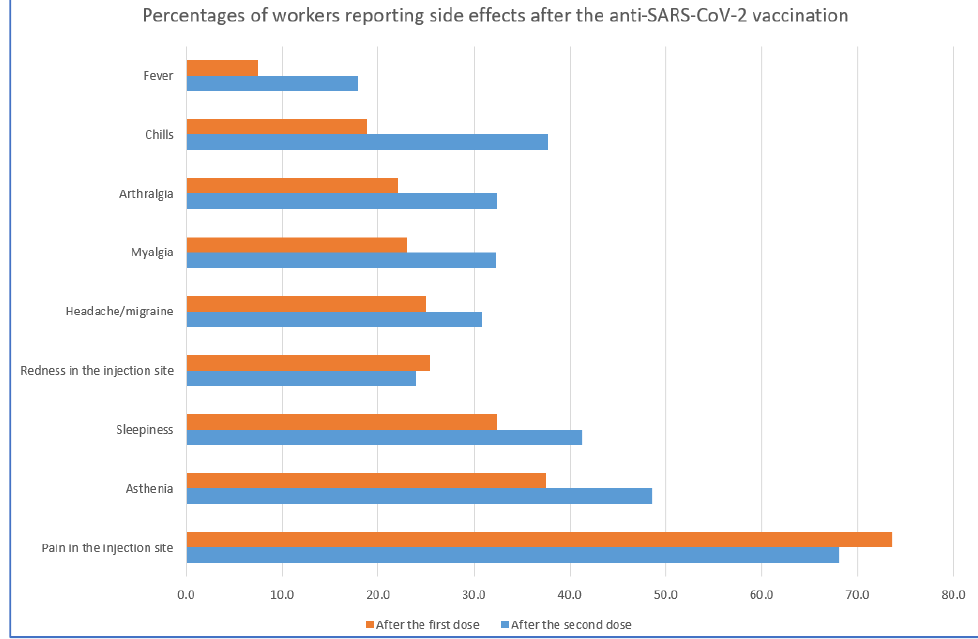
Figure 1. Percentage of workers reporting adverse effects after the first (red bar) and the second (blue bar) dose of the BNT162b2 anti-SARS-CoV-2 vaccine. NB: data on other adverse effects (including anaphylaxis, syncope, dyspnea, diarrhea, erythema, abdominal pain, itch, vertigo and taste alterations) with a frequency <8% are not shown here.